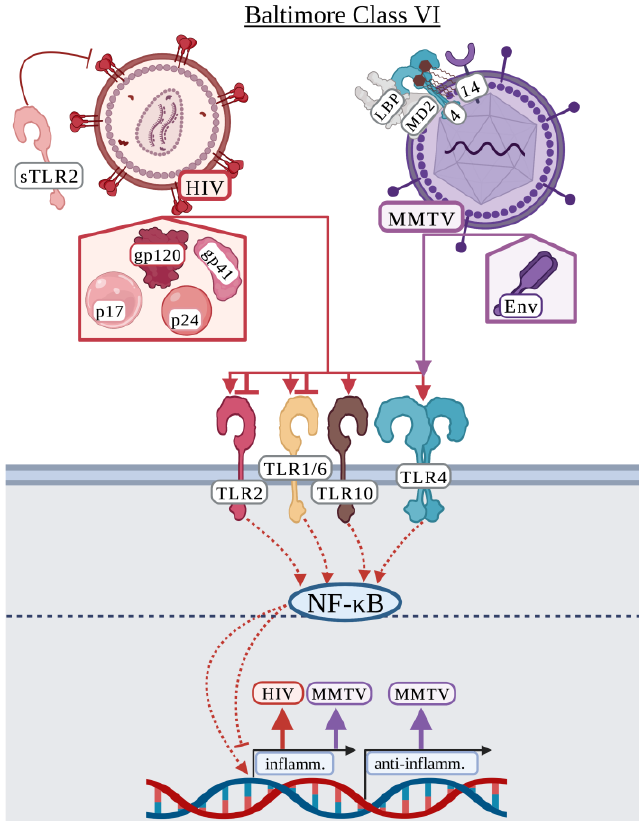
Figure 6. Baltimore Classification VI viruses recognized by surface TLRs: Baltimore Class VI include human immunodeficiency virus (HIV) and mouse mammary tumor virus (MMTV). HIV infection was shown to be blocked by soluble TLR2 (sTLR2) with HIV ligands being shown to act agonistically and antagonistically. HIV ligands including gp120, gp41, p17, and p24 either activated or inhibited TLR2/1, TLR2/6, and/or TLR4 for the activation or inhibition of an inflammatory response. MMTV is unique in that it ‘steals’ host associated TLR4, MD-2, LPS binding protein (LBP), and CD14 to associate with LPS to activate host TLR4 for both an inflammatory and anti-inflammatory response.